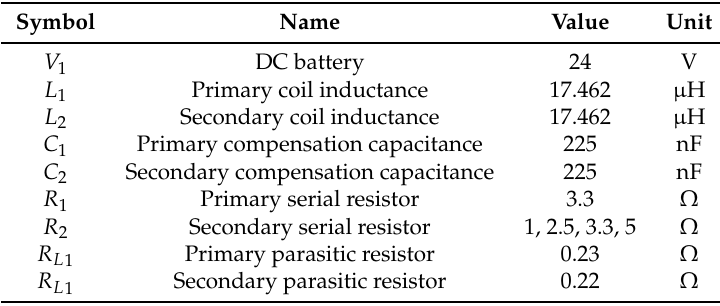
Table 1. Element parameters of the simulation schematic diagram.